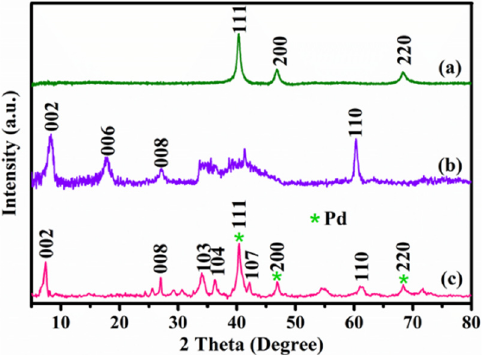
Figure 1. X-ray diffraction analysis ( a ) Pd NPs, ( b ) MXene, and ( c ) Pd-MXene